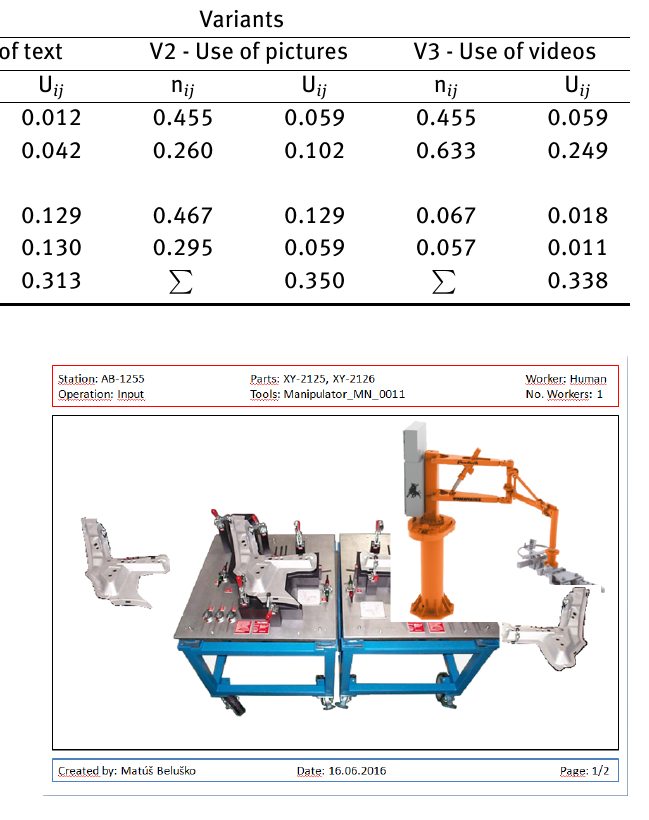
Figure 10: Instruction overwhelmed by